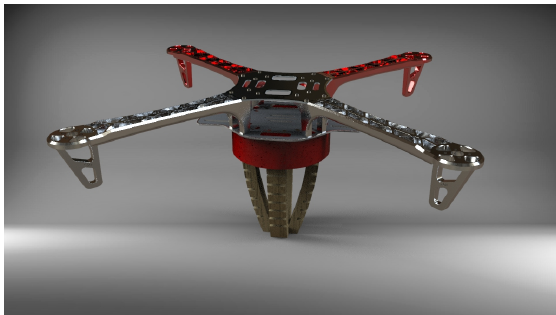
Figure 2. The 3D schematic of the proposed quadrotor helicopter.